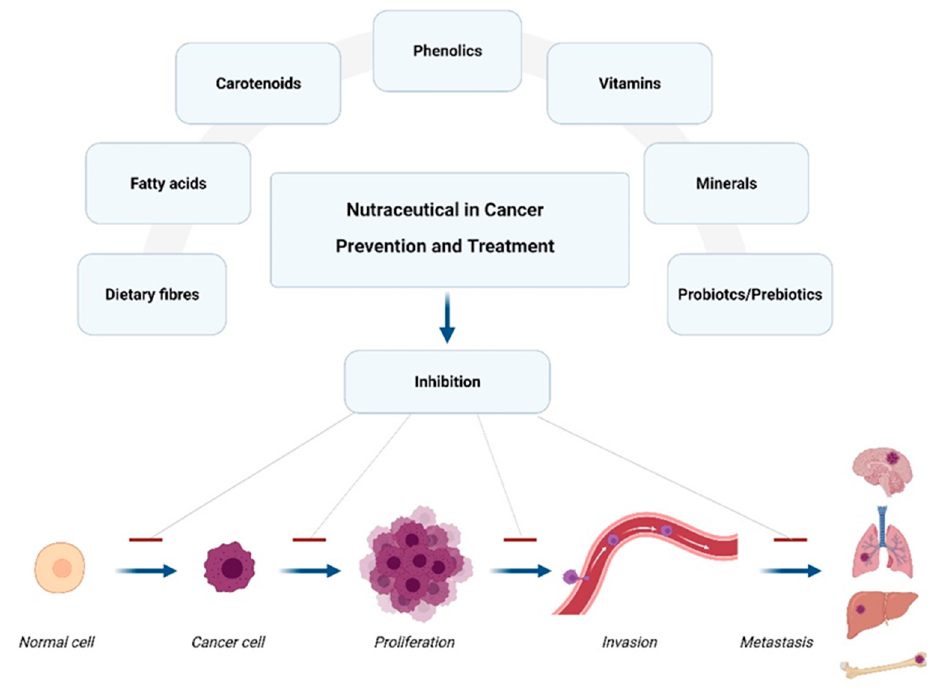
Figure 2. Schematic illustration of various kinds of nutraceuticals used in cancer prevention and treatment (Created with “https://www.biorender.com (accessed on 12 December 2023)”. treatment (Created with “https://www.biorender.com (accessed on 12 December